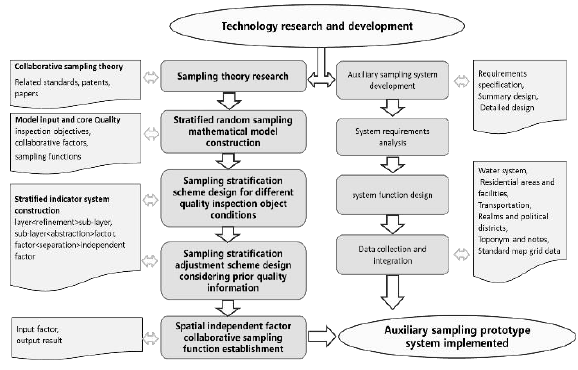
Figure 1. Technical